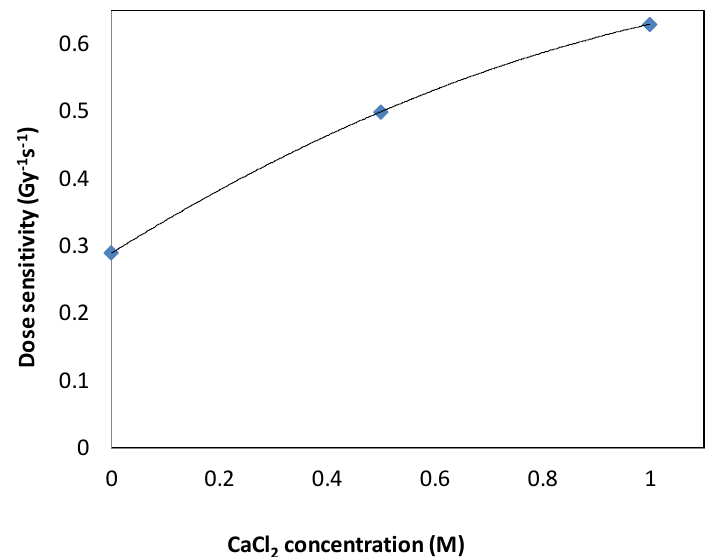
Figure 1. R 2 of gels with various concentrations of CaCl 2 when irradiated at doses up to ( a ) 0–10 Gy, and ( b ) 0 − 4 Gy. Error bars are the 2 σ of R 2 values.